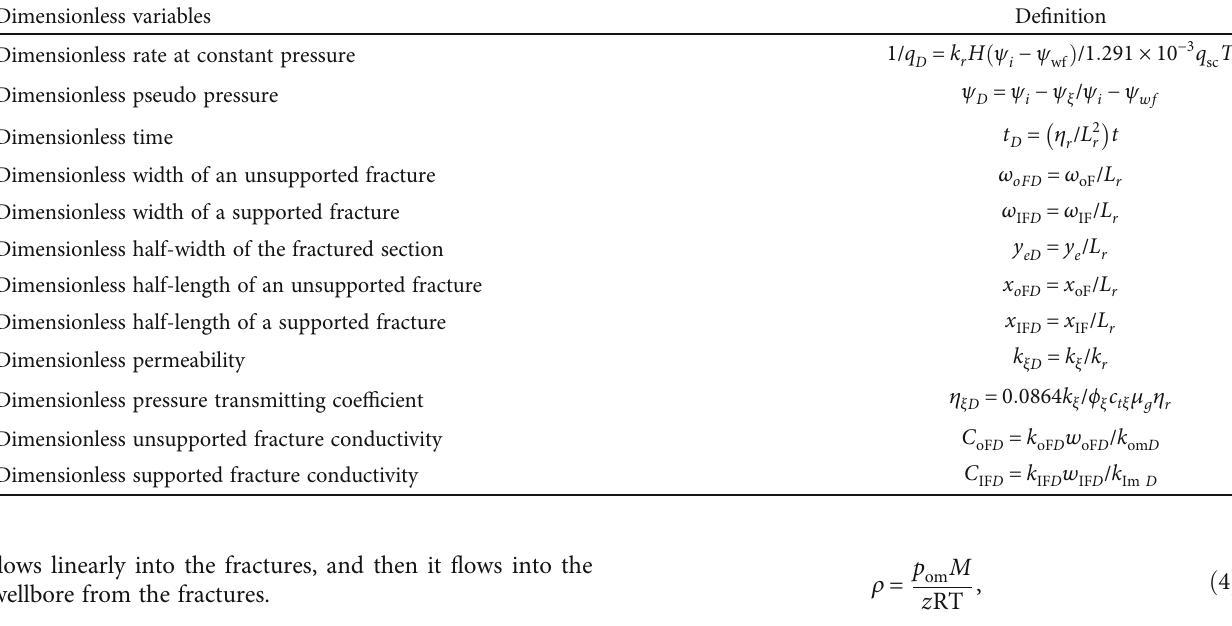
Figure 1: Schematic diagram of the fractured horizontal well model considering the uneven support of Table 1: De fi nition of the dimensionless variables.